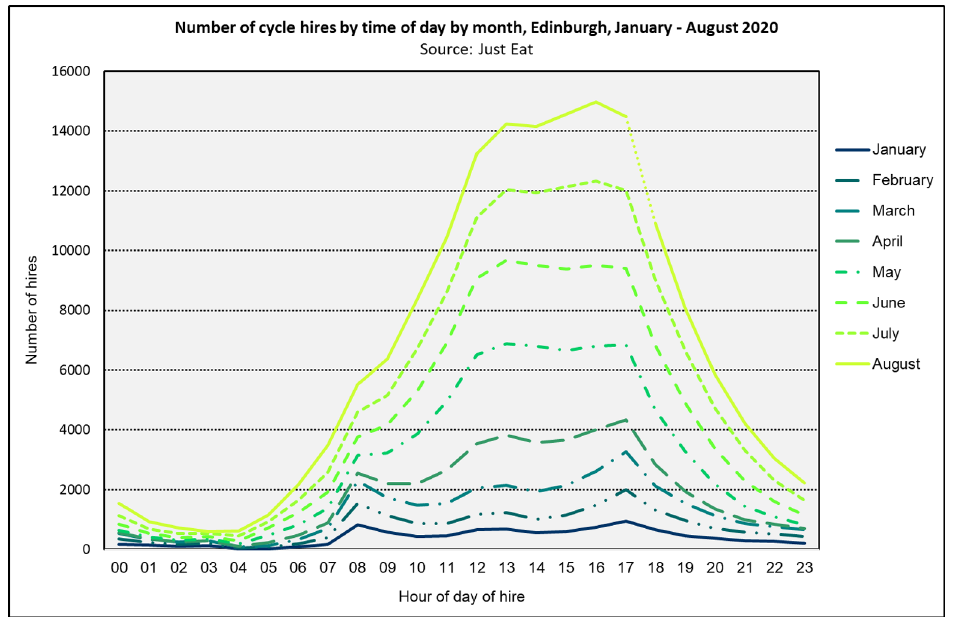
Figure 5: Number of cycle hires by time of day and by month, Edinburgh, January–August